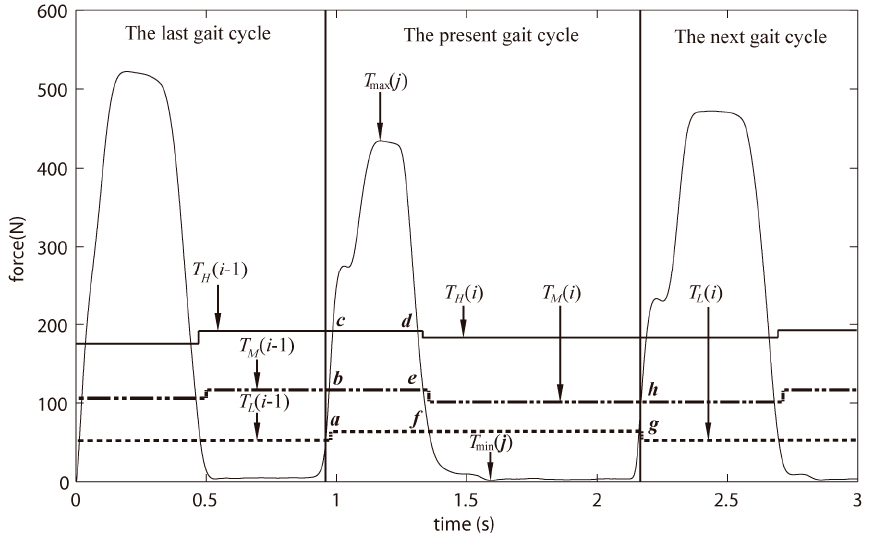
Figure 2. Three thresholds used for the GCFs processing.